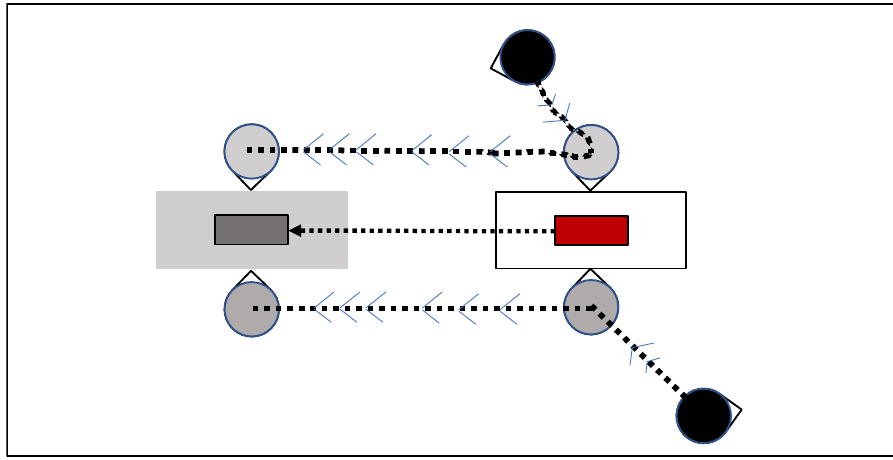
Figure 8. Experimental configuration.